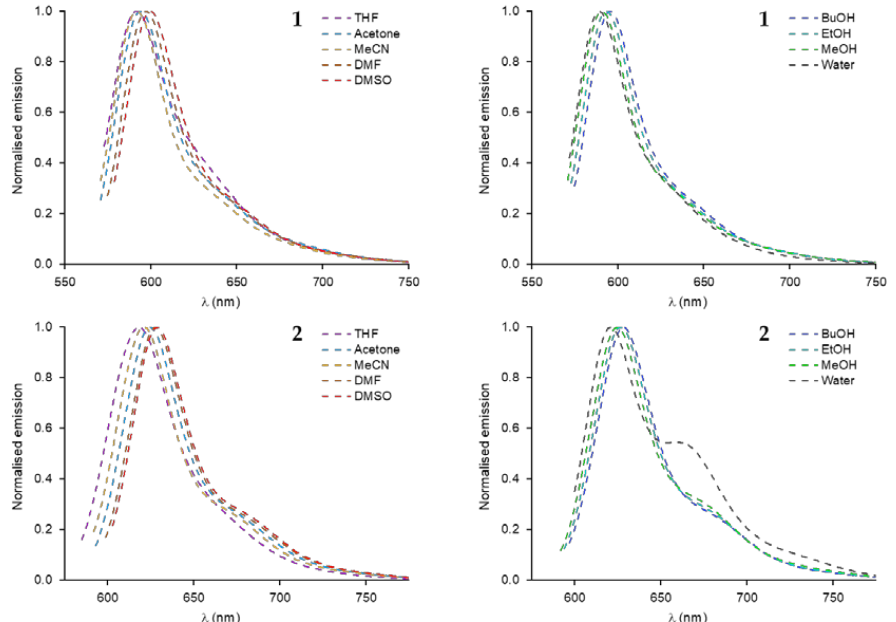
Figure 3. Normalized emission spectra of merocyanine dyes meroBA-COOH ( 1 ) and meroSO-COOH ( 2 ) in a series of aprotic ( left ) and protic solvents ( right ). Measurements were performed on solutions with optical densities ≤0.1 (ca. 1 µM). Investigation of their optical properties in the range of solvents tested showed only a